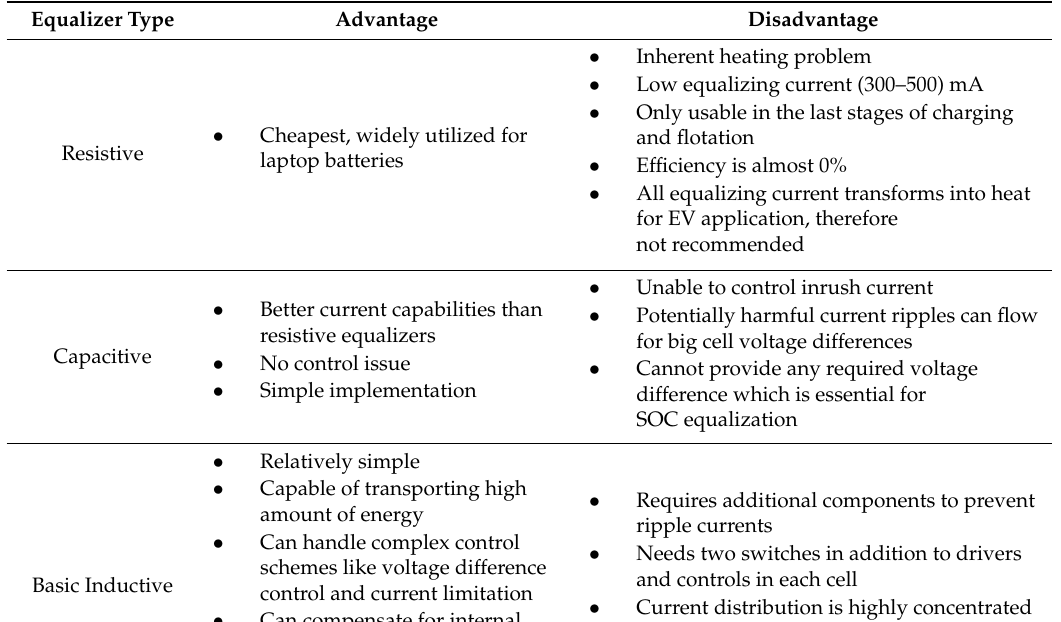
Table 8. Advantages and disadvantages of different equalizer types. Data from [46–52].